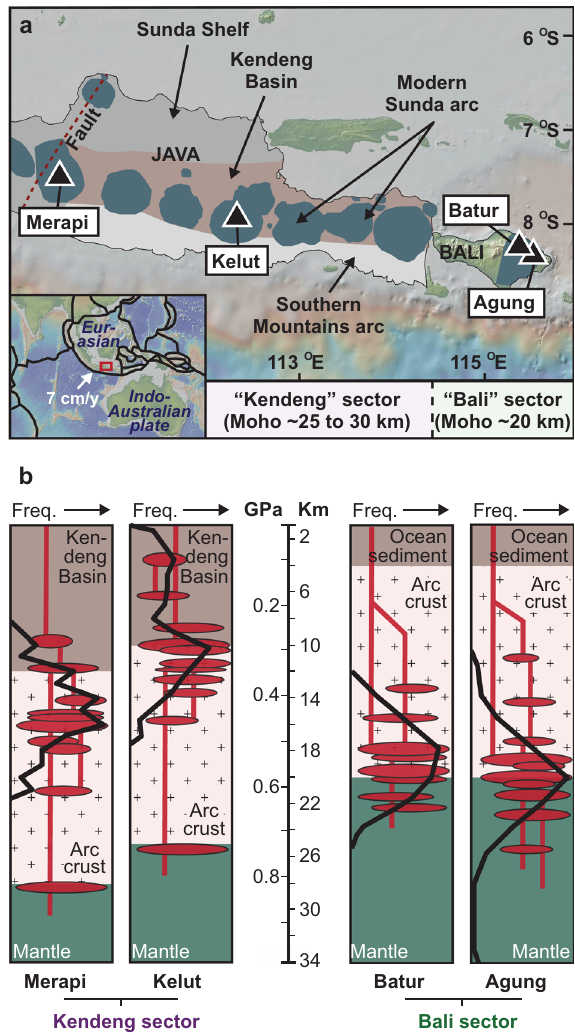
Fig. 1 Study area and magma storage in Java and Bali. a Map of Central to East Java and Bali showing the location of Merapi, Kelut, Batur, and Agung volcanoes. The modern Sunda arc volcanoes in Central to East Java (dark grey) are mainly built on the Kendeng Basin (brown), but overlap locally with the Miocene Southern Mountains arc. Inset shows the regional tectonic setting with the study area in a red box. Maps in a were produced using GeoMapApp (www.geomapapp.org) 74 with geological information from ref. 59 . b Summary of thermobarometric models constructed using clinopyroxene mineral data from the samples utilised in this study. Black curves represent the frequency of crystallisation depths calculated from clinopyroxene mineral data (data from refs. 12 – 14 ). Note that clinopyroxene from the Merapi and Kelut samples crystallised dominantly in the arc crust (including the Kendeng Basin), whereas clinopyroxene from the Balinese samples crystallised at the crust – mantle boundary and within the upper mantle. Abbreviations: Freq., frequency; Moho, Mohorovi č i ć